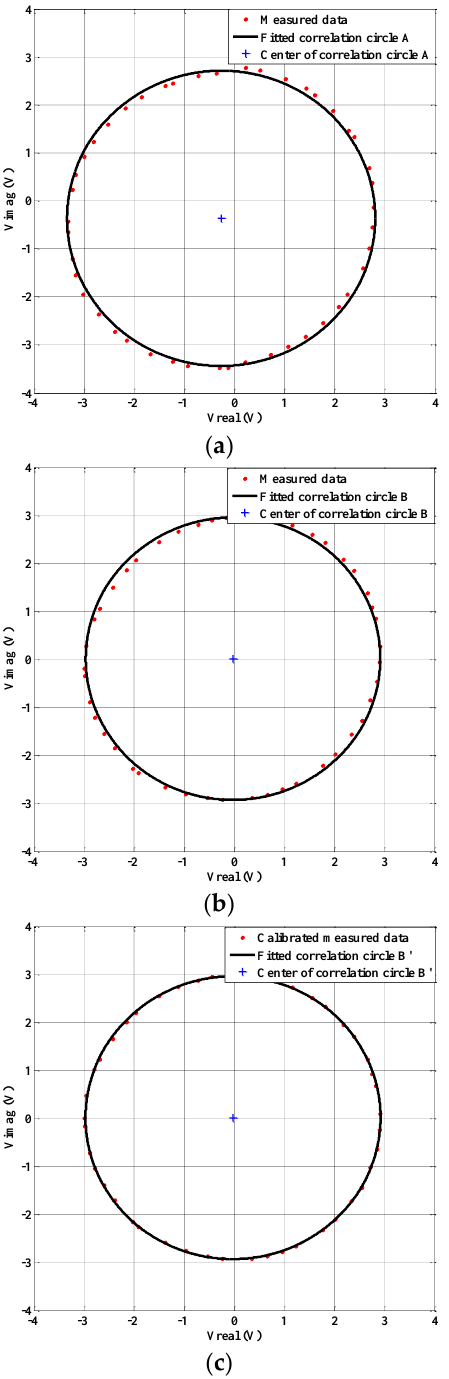
Figure 8. ( a ) The measured output correlation circle without hardware calibration; ( b ) the measured output correlation circle with hardware calibration; and ( c ) the output correlation circle after the quadrature errors calibration.